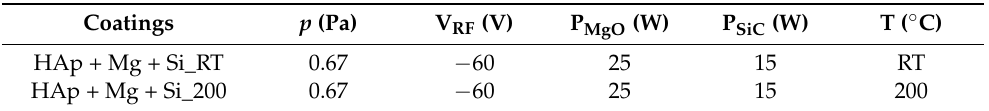
Table 2. The deposition conditions: p —pressure, V RF —RF bias on substrates, P—power applied on the cathode, T—deposition